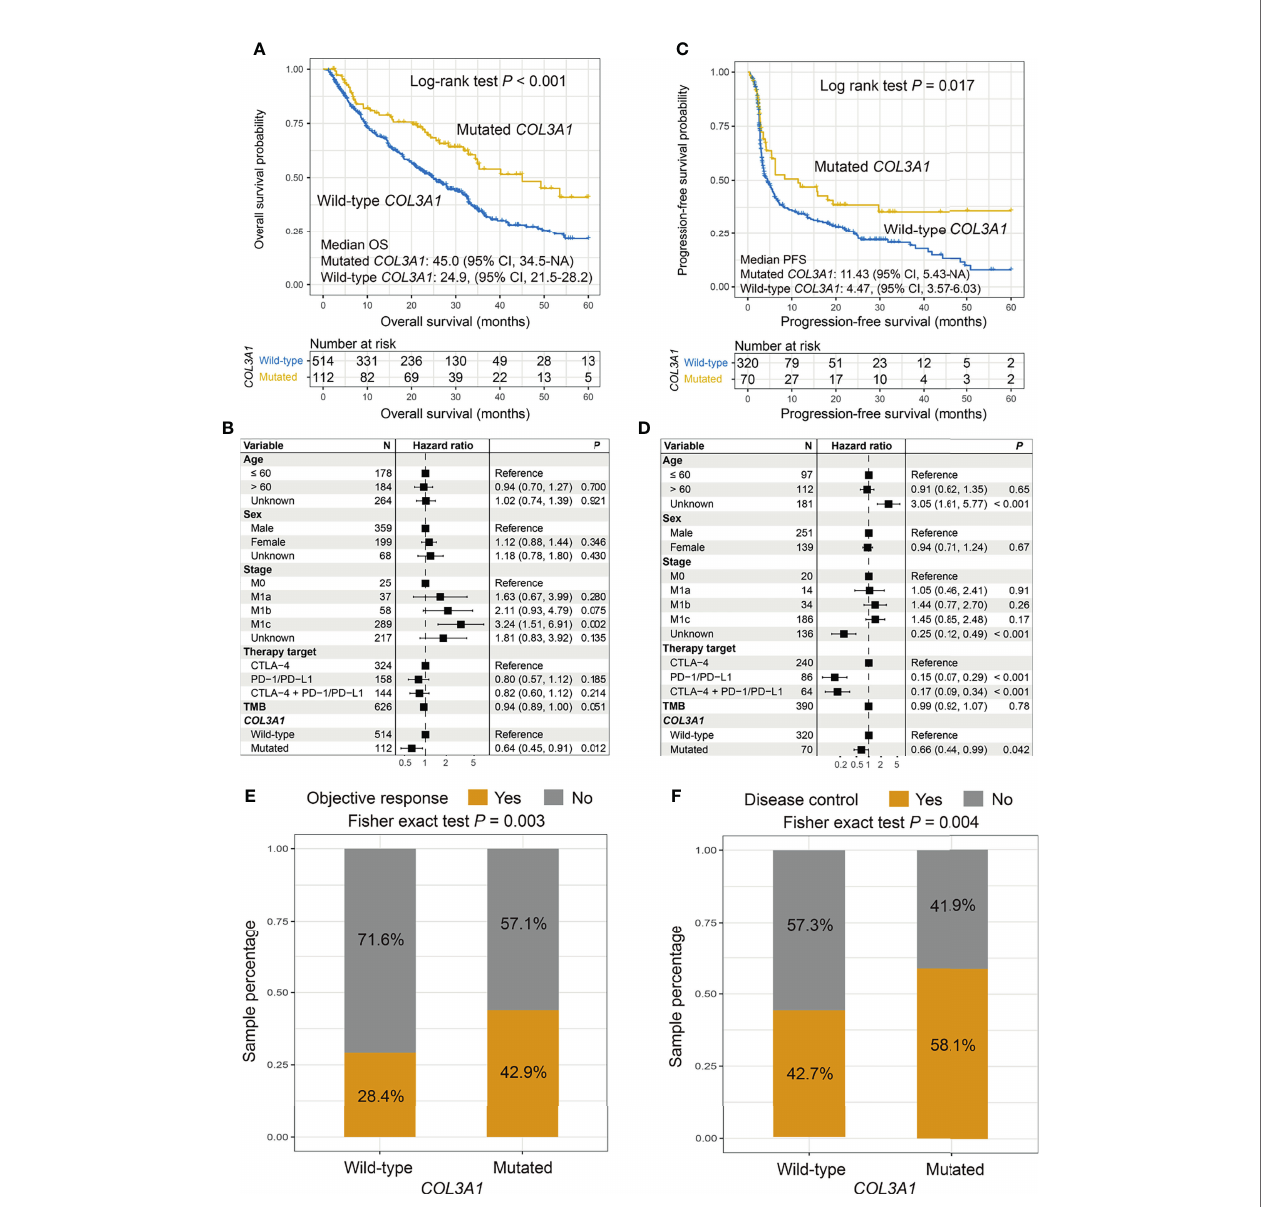
FIGURE 2 | Association of COL3A1 mutations with immune checkpoint inhibitor (ICI) survival outcome and response. Kaplan – Meier survival analyses and multivariate Cox regression models with confounding factors taken into account were conducted to evaluate the links of COL3A1 mutations with (A, B) overall survival (OS) and (C, D) progression-free survival (PFS). COL3A1 mutations are associated with (E) objective response rate (ORR) and (F) disease control rate